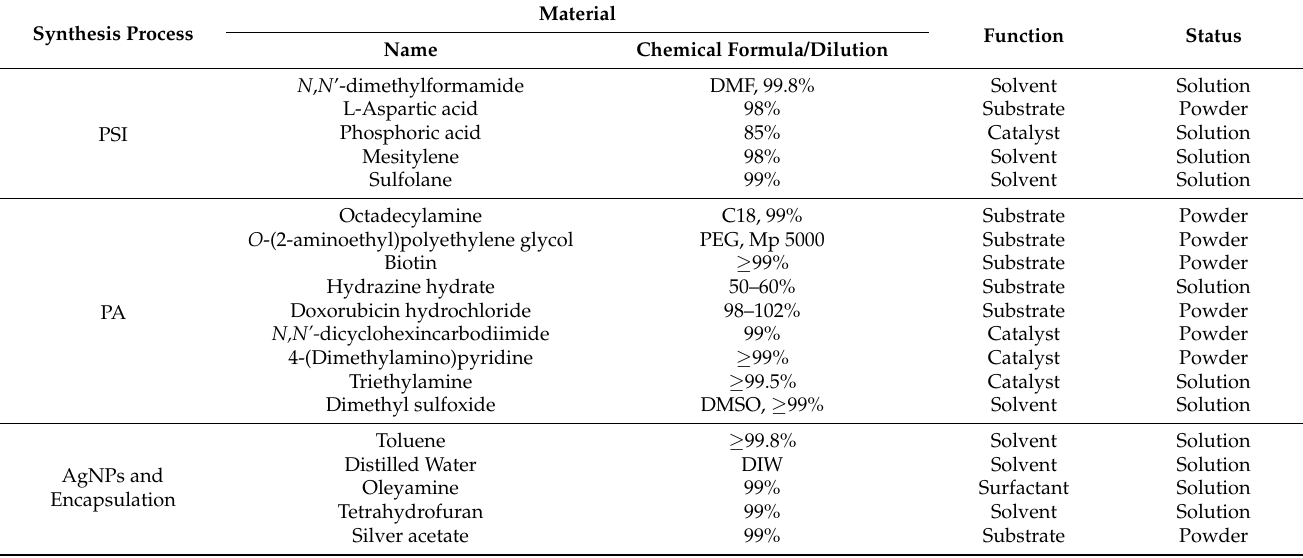
Table 1. Summary of all materials